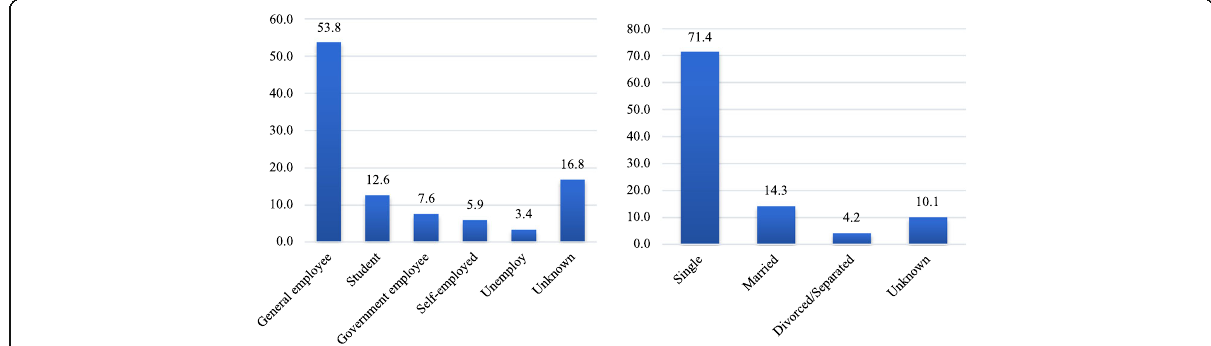
Fig. 2 Percent of occupation (left) and marital status (right) of